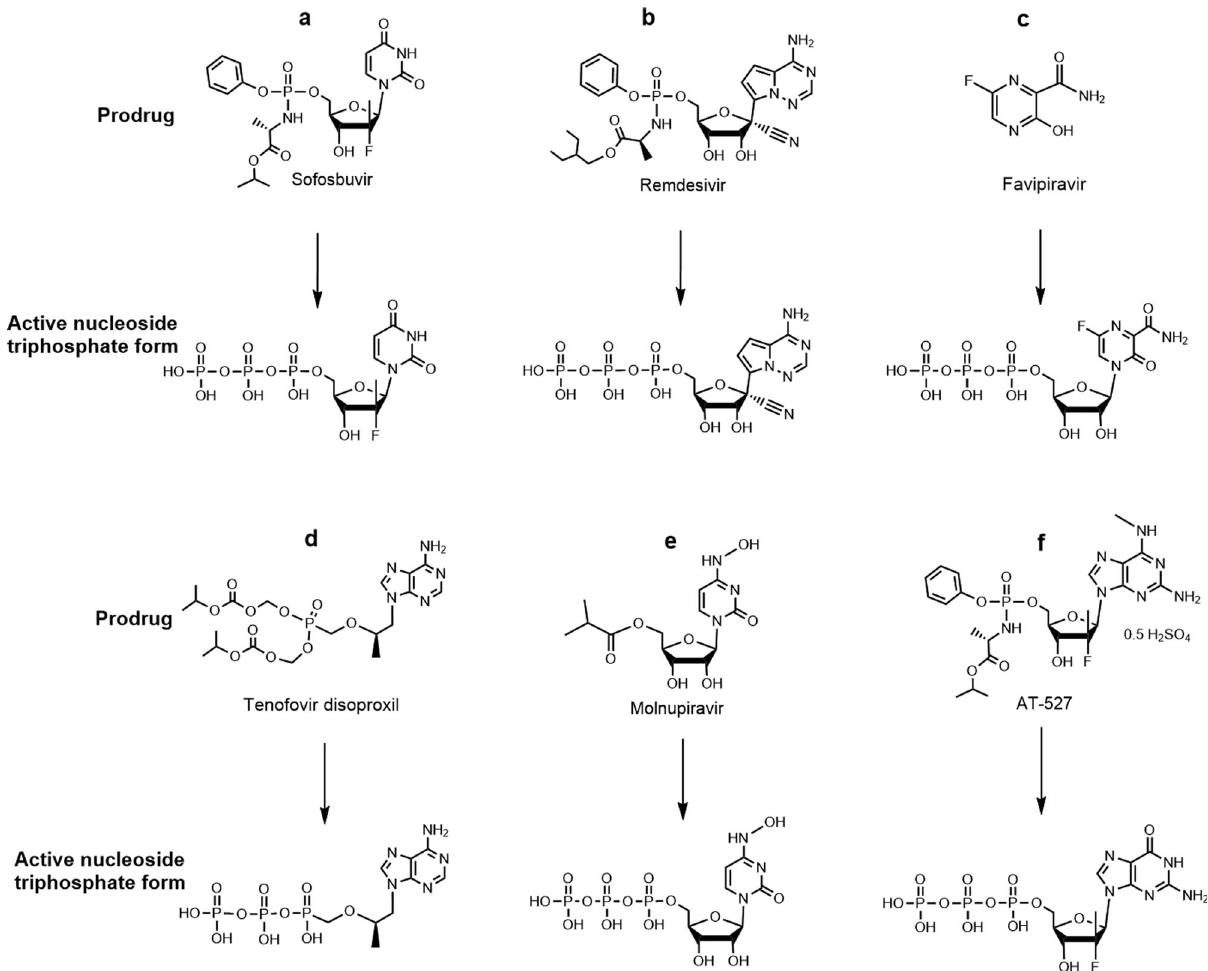
Fig. 1 Prodrugs and their active triphosphate forms. Structures of the prodrugs Sofosbuvir ( a ), Remdesivir ( b ), Favipiravir ( c ), Tenofovir disoproxil ( d ), Molnupiravir ( e ), and AT-527 ( f ) (top) and their respective active triphosphate forms Sofosbuvir-5 ’ -triphosphate, Remdesivir-5 ’ -triphosphate, Favipiravir- ribofuranosyl-5 ’ -triphosphate (Favipiravir-RTP), Tenofovir diphosphate, N 4 -hydroxycytidine-5 ’ -triphosphate (NHC-TP), and 2 ’ - fl uoro-2 ’ -methyl guanosine- 5 ’ -triphosphate (AT-9010, G fm -TP)